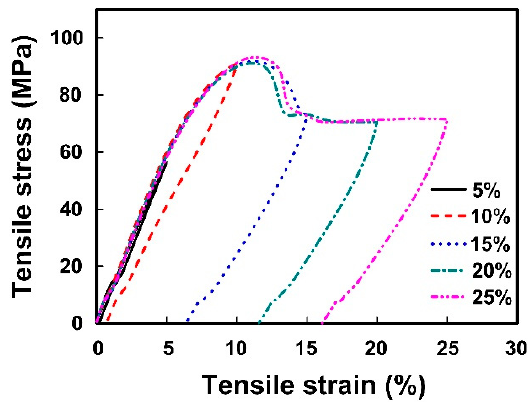
Figure 6. Typical stress versus strain relationships in uni-axial tension to five different programming strains at room temperature, and then followed by unloading.